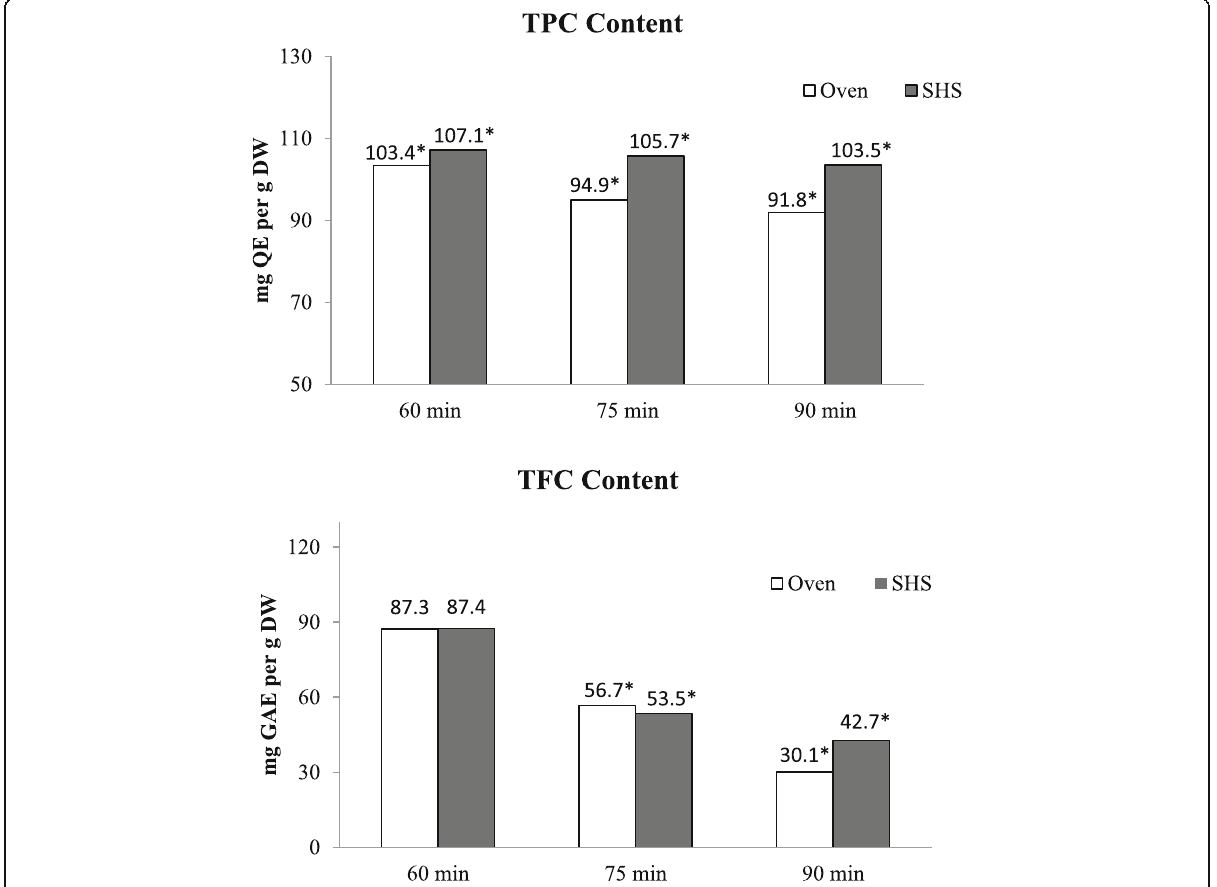
Fig. 5 Comparison of total phenolic and flavonoid contents between oven dried and SHS dried tea leaves at different drying duration. (*) indicates significant differences ( p < 0.05) between values at the same time based on independent sample t-test. (SHS = Superheated